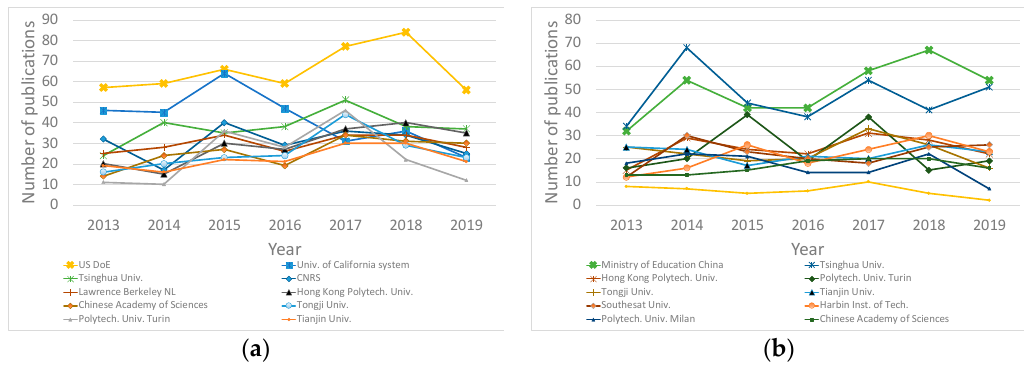
Figure 9. Trends in the number of publications in the area of study per institution: ( a ) Web of Science; ( b ) Scopus.